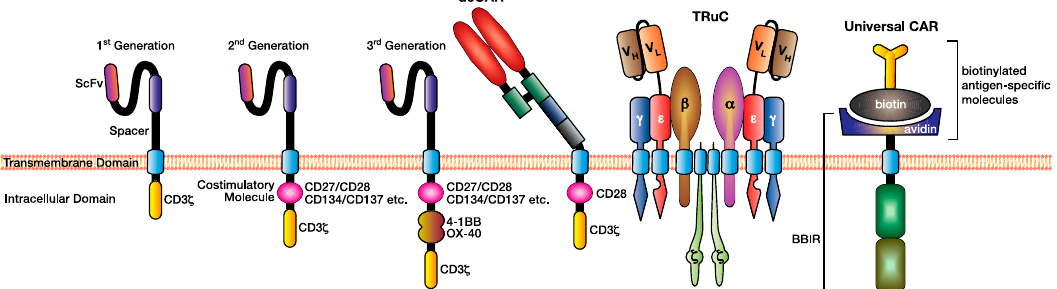
Figure 2. Various modifications have been made to the CAR design to facilitate superior antigen targeting, CAR T cell function, and applicability. This figure illustrates three generations of CAR design (first, second, and third) depending on the addition of costimulation domains, the dual